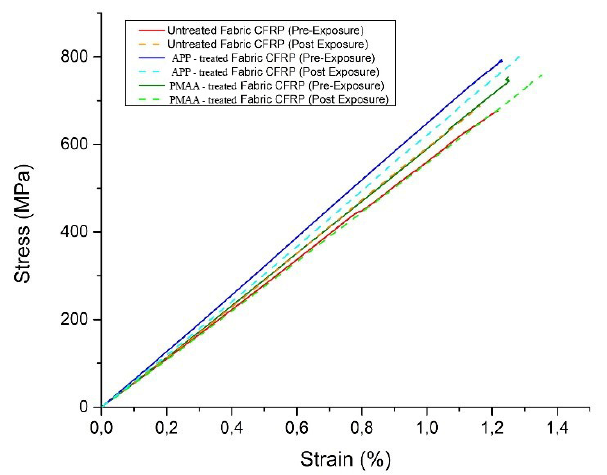
Figure 7. Tensile stress-strain curves for CFRPs prior and after the exposure.